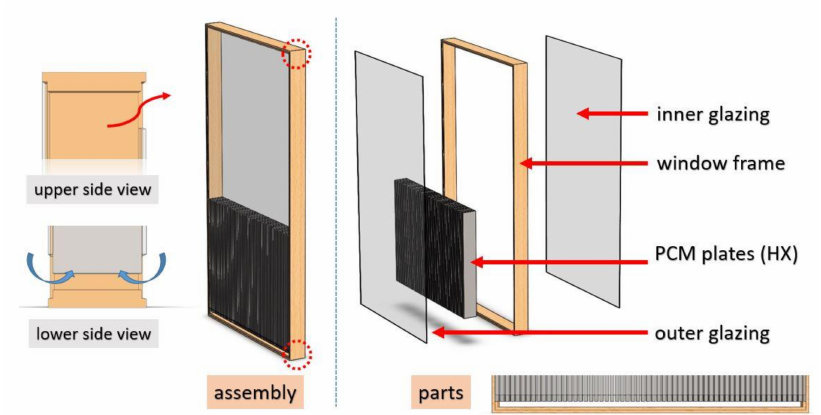
Figure 5. Ventilated window with PCM heat exchanger [61].